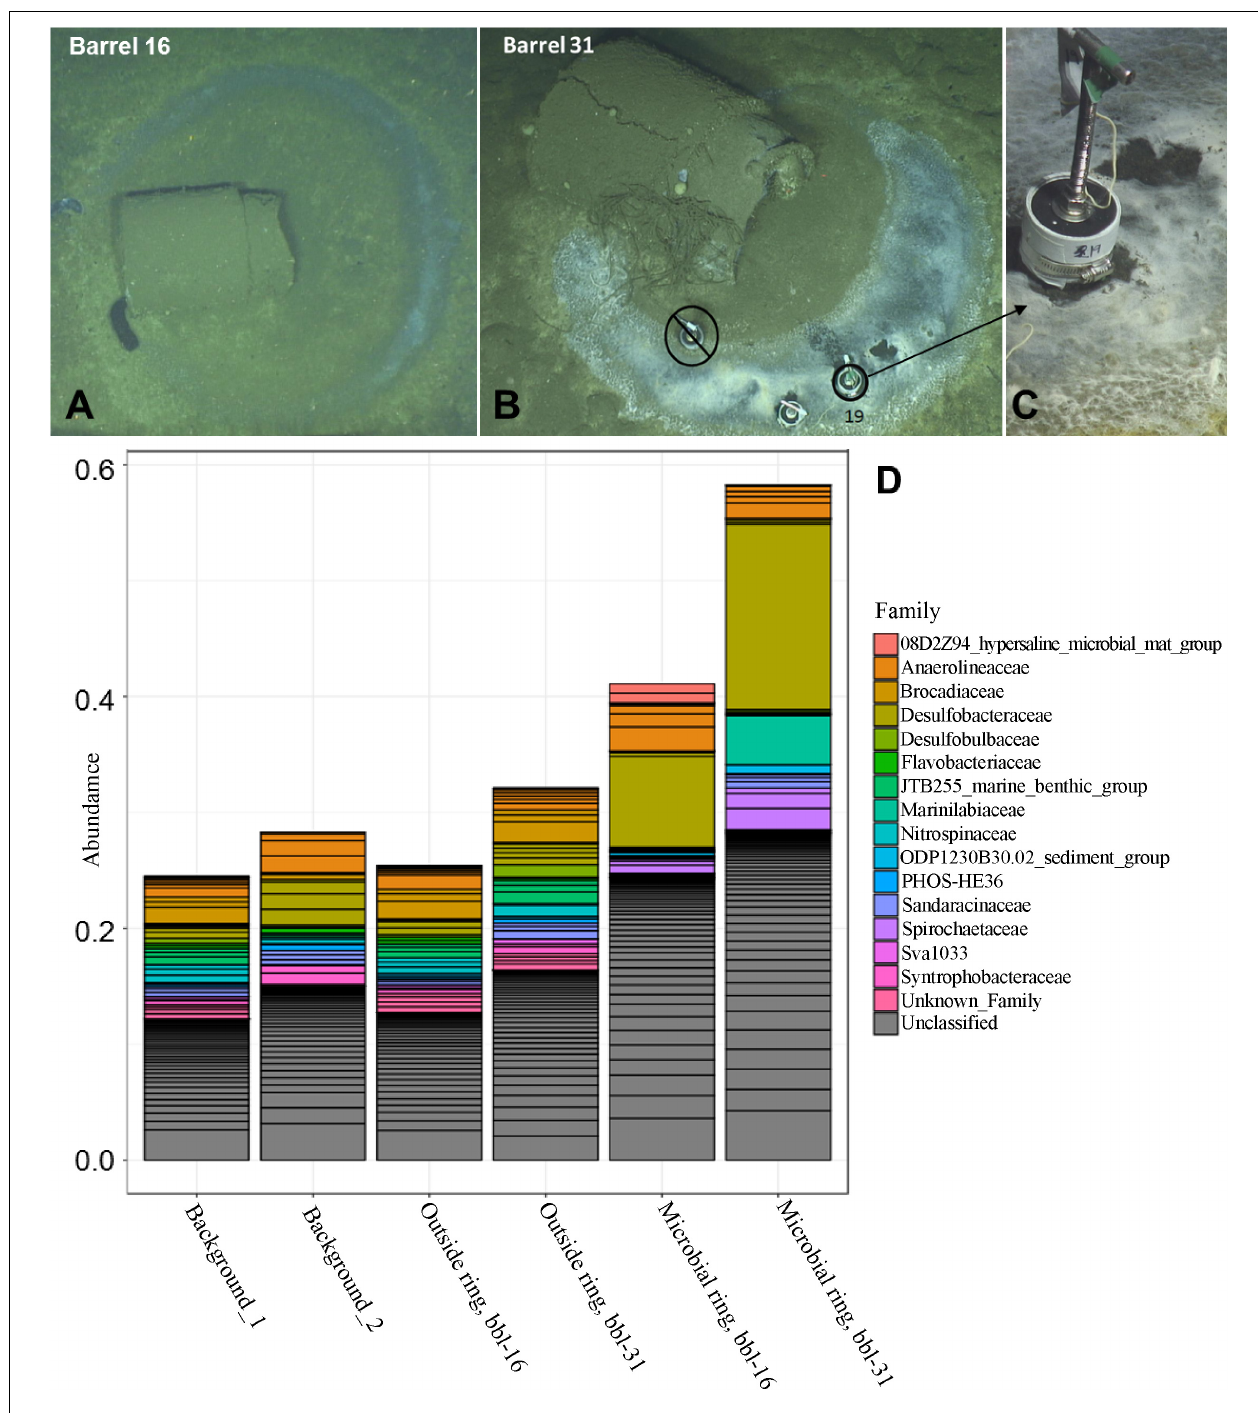
FIGURE 1 | (A) Barrel 16 encircled by a microbial mat ring (B) Barrel 31 with microbial mat ring; sediment collection site of Core 19. (C) Close-up of Core 19 at barrel 31 microbial mat (D) Abundance of top taxa by sample for background, outside ring, and microbial ring